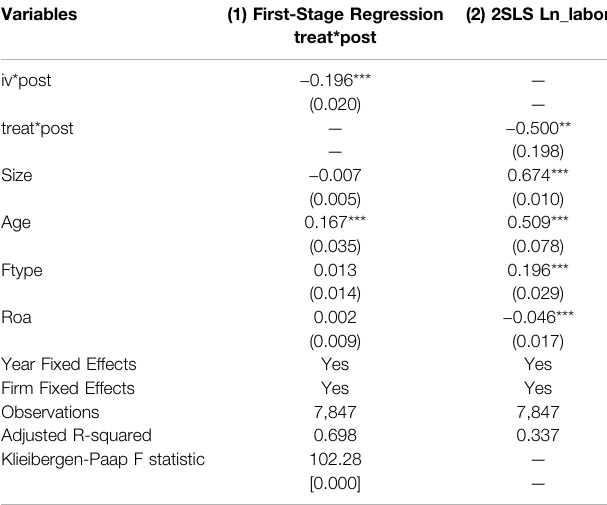
TABLE 5 | Estimation results of PSM-DID and excluding samples after 2013. Variables